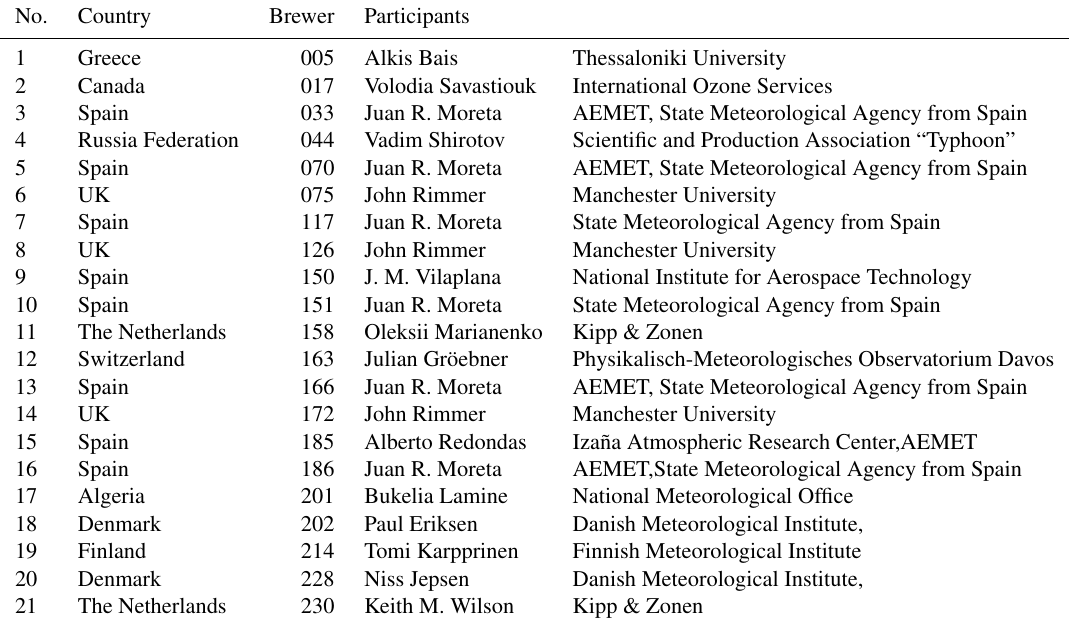
Table 1. Principal investigators and instruments participating on the X RBCC-E campaign.